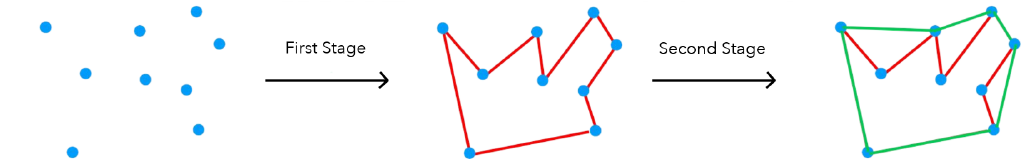
Figure 2. Two sequential stages for Graham’s scan algorithm.